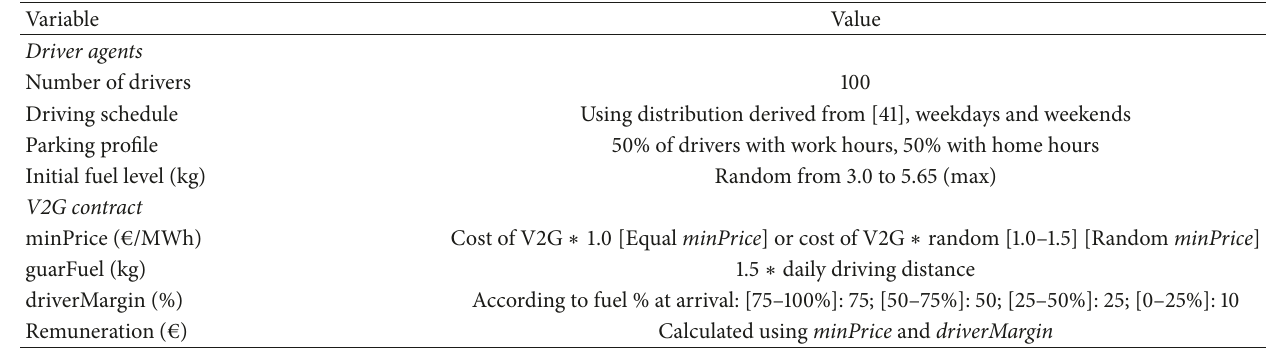
Table 4: Drivers and V2G contract